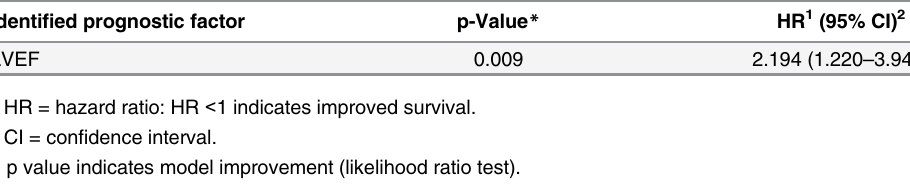
Table 5. Overall survival: Explanatory prognostic factors in a Cox proportional Hazards model for the selected study collective. Included variables: sex (male (ref.) vs . female), age ( < 80 years (ref.) vs . (cid:1) 80